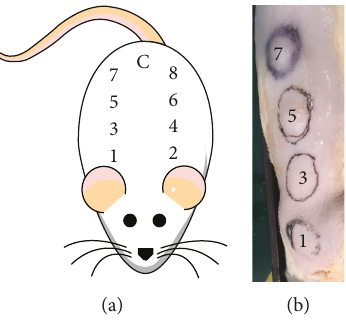
Figure 5: Injections of microspheres in the rat. (a) Temporal sequence of eight injections of microspheres in the rat spaced in intervals of approximately 3 × t RGin vitro /8 ; C is an untreated control site for background fl uorescence determination. (b) Photograph of tattoo-marked SC injection sites labeled 1, 3, 5, and 7 at termination of the experiment where 1 is the oldest injection with almost completely degraded microspheres and 7 is the newest injection with fully intact microspheres. Tattoo circles are approximately 12 mm in